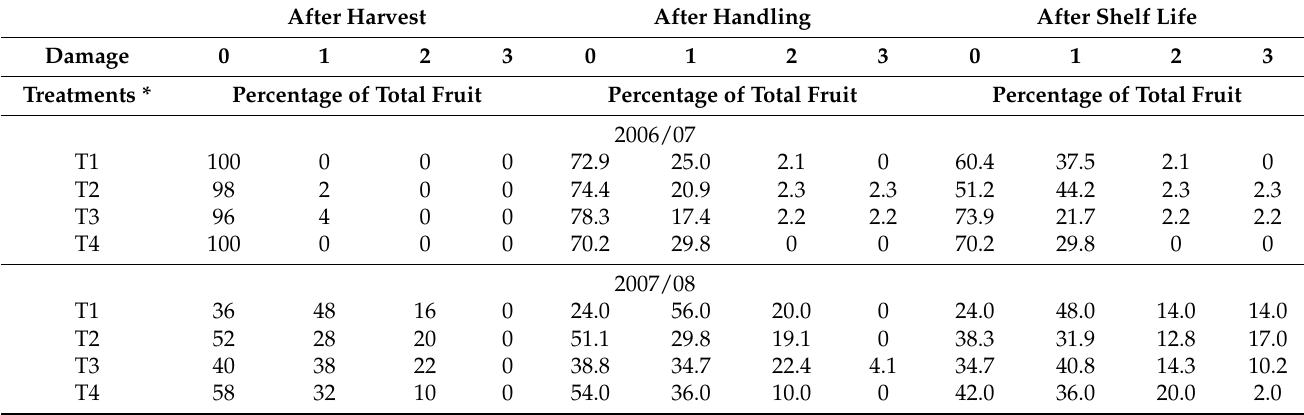
* T1: No irrigation during six weeks after harvest; T2: No irrigation during six weeks after harvest plus nine extra weeks of no irrigation from the rapid fruit growth phase to harvest; T3: No irrigation during six weeks after harvest plus six extra weeks of no irrigation from color break to harvest; and T4: No irrigation during six weeks after harvest plus 2–3 extra weeks (depending on the season) of no irrigation from rapid fruit growth to color break. For more details, see Table